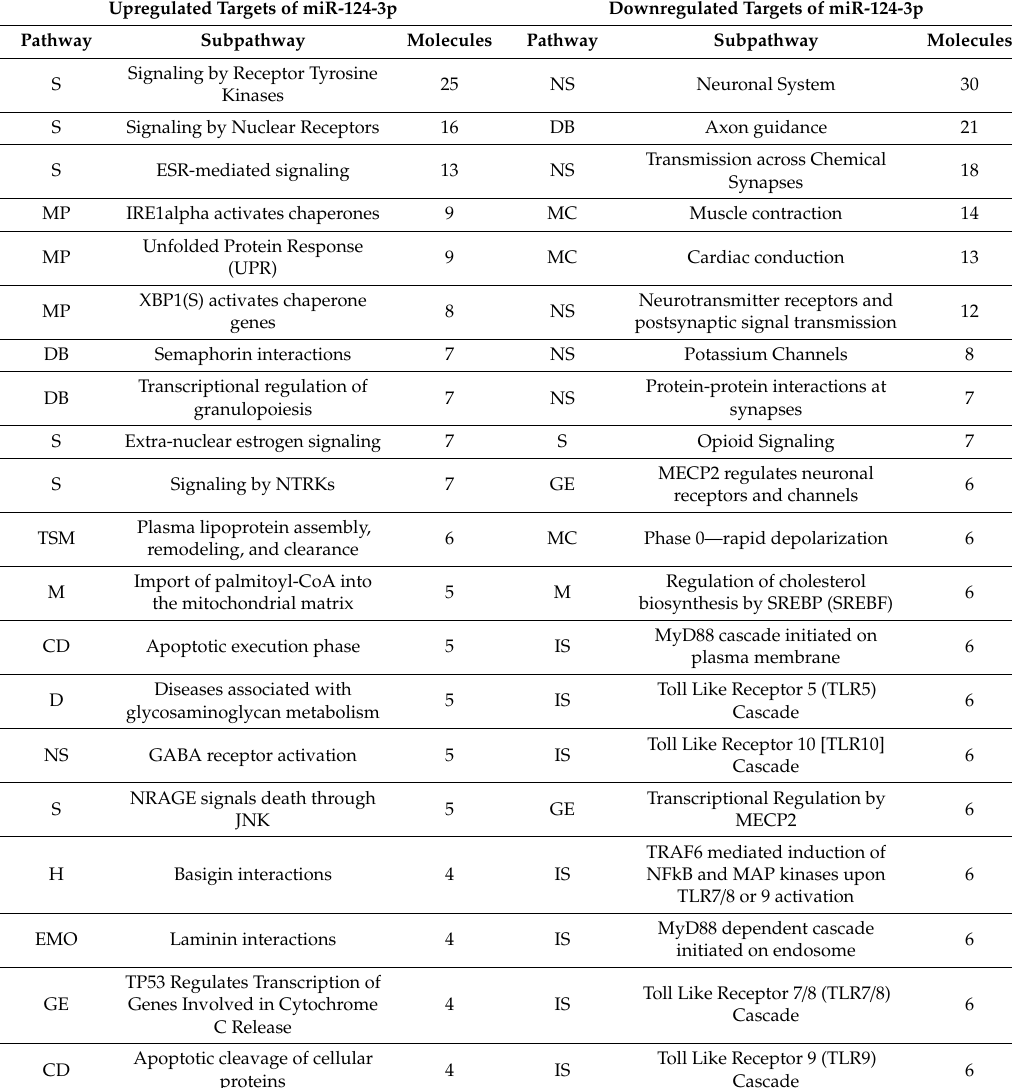
Table 2. The Reactome analysis linked the TBI-regulated targets of miR-124-3p to signal transduction and immunity. The 20 pathways with the most mapped targets are